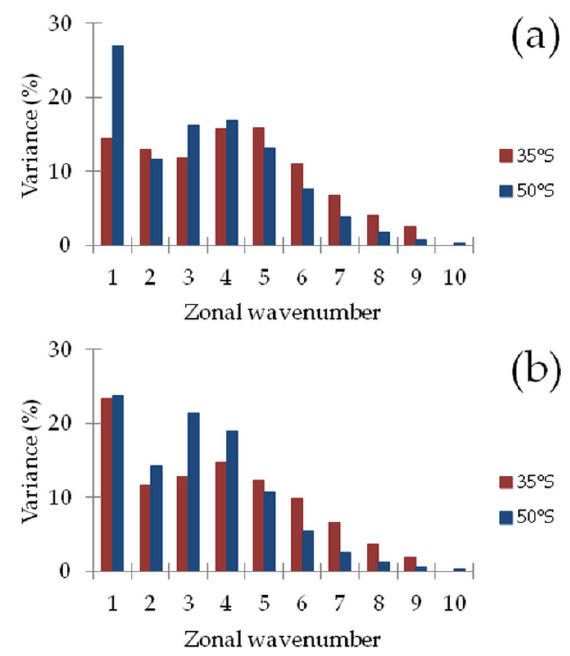
Figure 1. Average variance of waves 1 to 10 at 35° S and 50° S during two different seasons within the 74-year period: ( a ) DJF; ( b ) JJA.